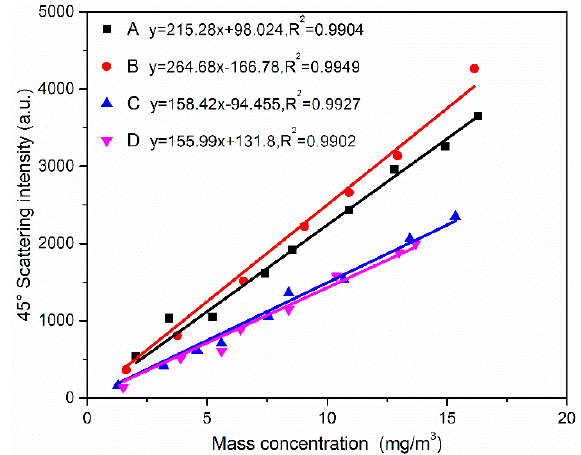
Figure 13. The correlation of scattering intensities measured by the fixed detector with mass concentration measured by the reference method for the particles A, B, C, and D.